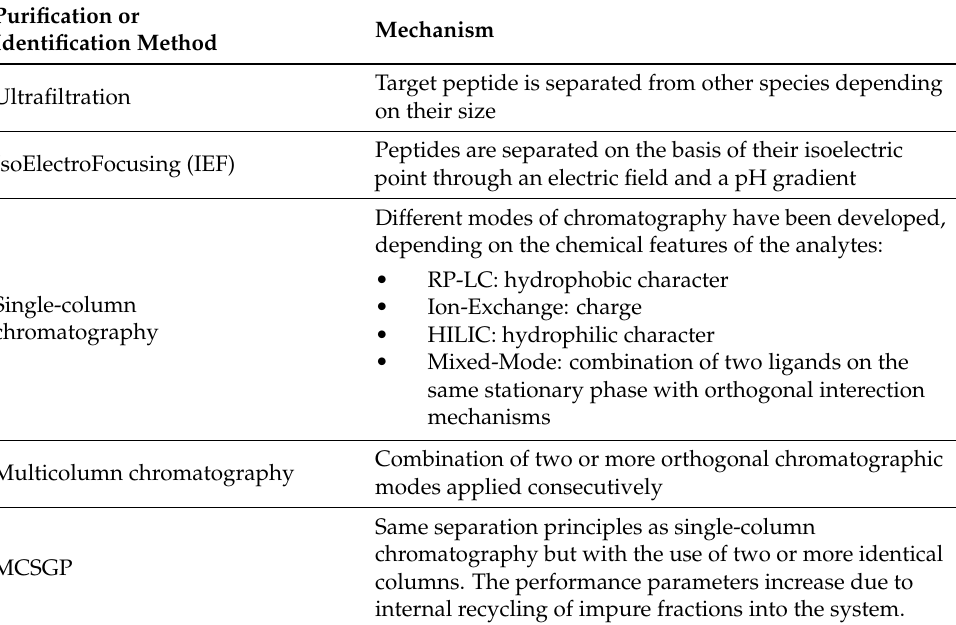
Table 1. In this table, the main techniques employed for peptide purification and their interaction mechanisms are